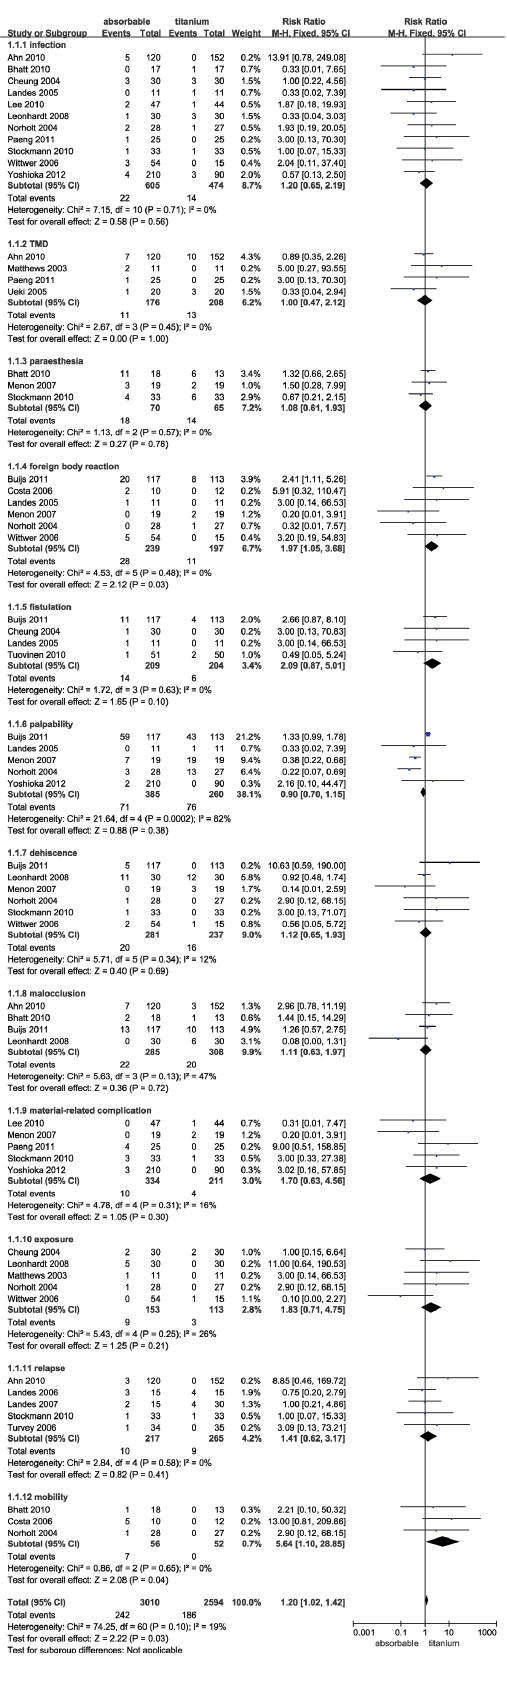
Figure 2. Forest plot of trials of absorbable fixation versus titanium examining the effect on relative risk of complications in all enrolled trials. TMD=temporomandibular joint dysfunction; df=degrees of freedom;